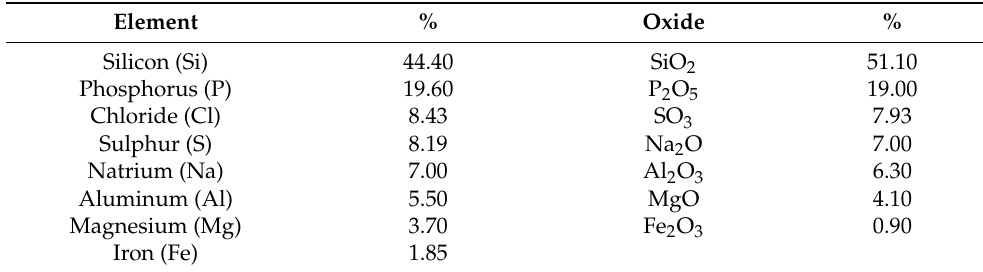
Figure 2. Energy-dispersive X-ray fluorescence spectrum of the n-clay. Table 2. Major elements and oxide levels of the n-clay.